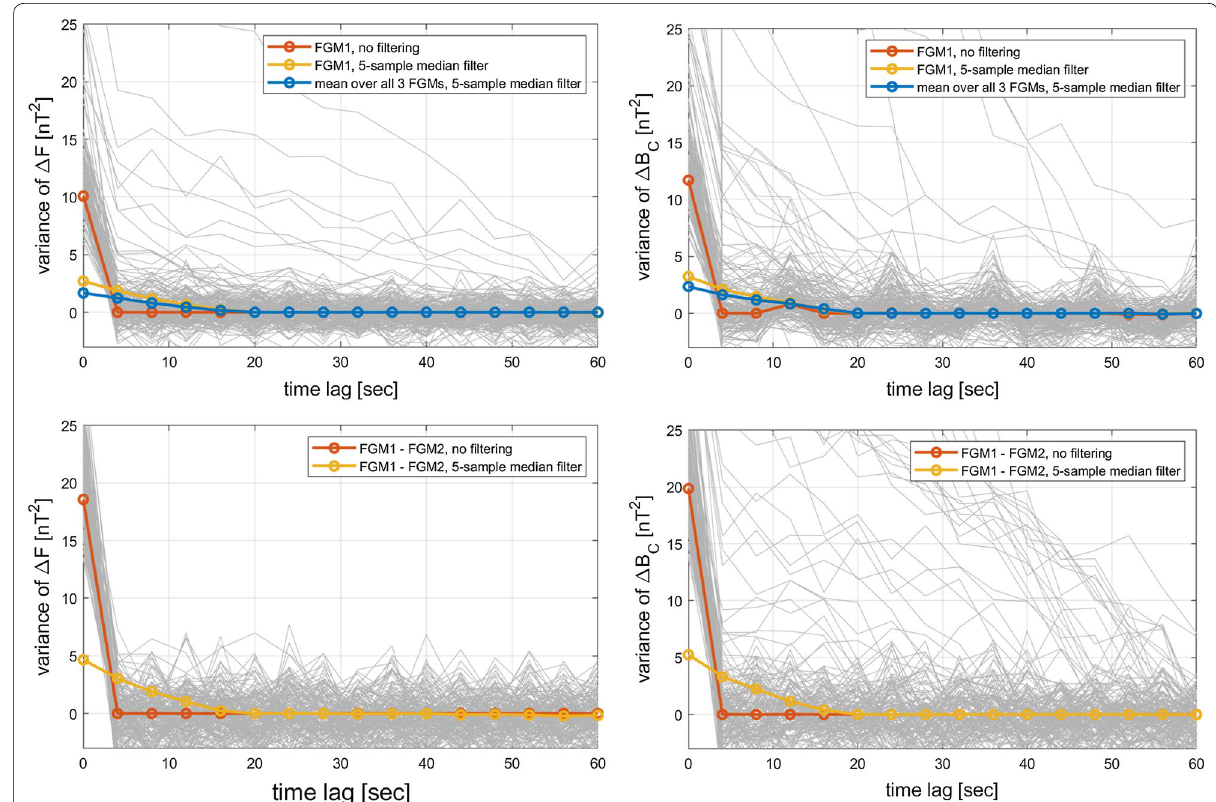
Fig. 6 Auto‑covariance function for 320‑s‑long data segments at non‑polar latitudes from 5. January 2011. Grey curves show the auto‑covariance functions of each data segment; red curve presents the median curve. See text for